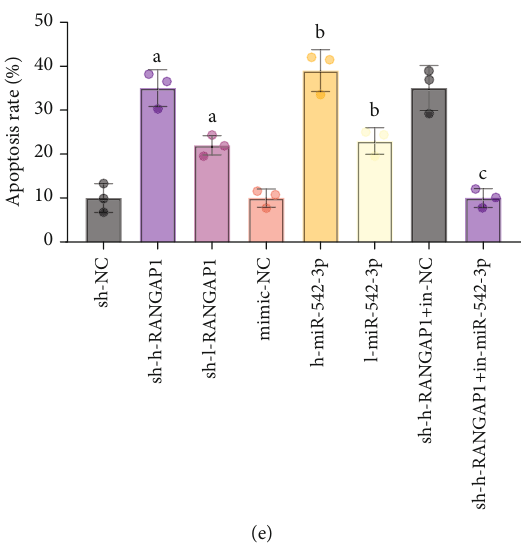
Figure 3: The cell proliferation and apoptosis in each group. (a) Test of the proliferation capacity of MG63 cells in the sh-NC, the sh-h- RANGAP1, and the sh-l-RANGAP1 was via CCK-8 assay. (b) Detection of MG63 cell proliferation in the mimic-NC, the h-miR-542-3p, and the l-miR-542-3p was via CCK-8 assay. (c) Examination of MG63 cell proliferation in sh-h-RANGAP1+in-NC and the sh-h- RANGAP1+in-miR-542-3p was via CCK-8 assay. (d) Detection of MG63 cell apoptosis in each group was via fl ow cytometry. (e) Test of the apoptosis rate of MG63 cells in each group was via fl ow cytometry. The data in the fi gure were all measurement data in the form of mean ± SD . a represented P < 0 : 05 versus the sh-NC; b represented P < 0 : 05 versus the mimic-NC; c represented P < 0 : 05 versus the sh-